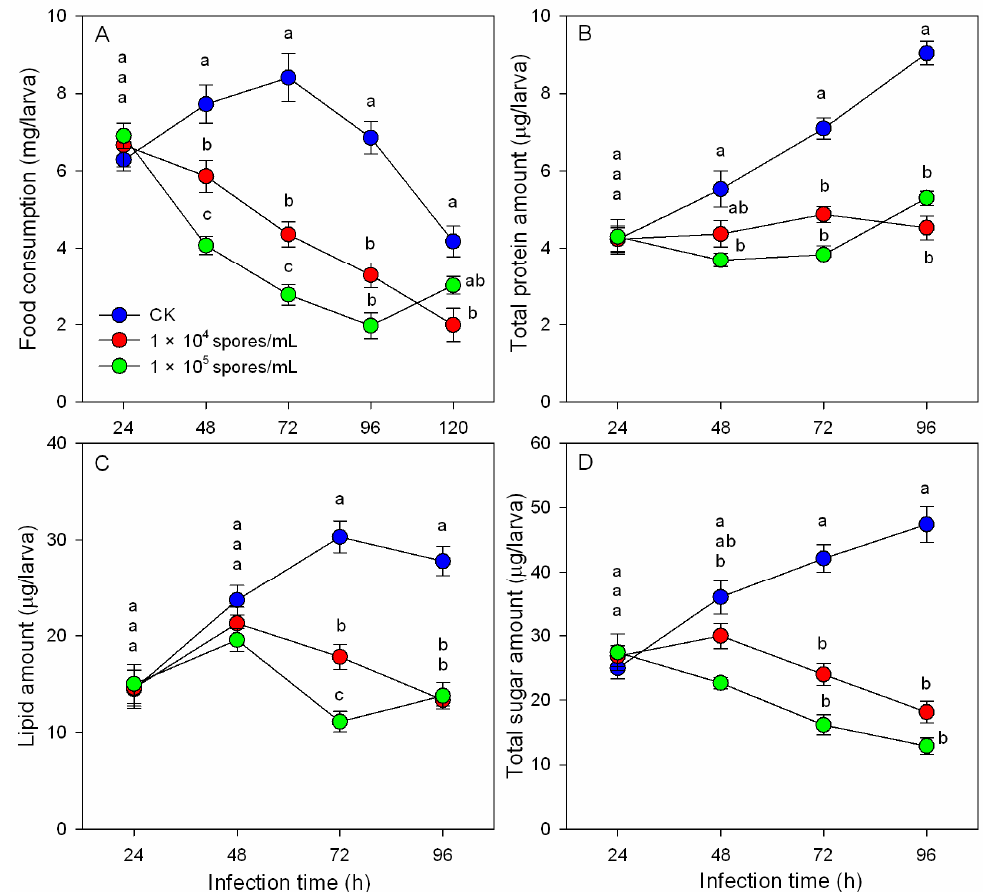
Figure 1. Effects of M. hiemalis infection on food consumption ( A ) and nutrient contents (( B ), protein amount; ( C ), lipid amount; ( D ), sugar amount) of B. odoriphaga. Data in the figure are the mean ± SE. Different letters over the same column indicate significant differences between different spore con ‐ centration treatments at the p < 0.05 level by one ‐ way ANOVA. Different letters (a and b) over the same column indicate significant differences between different spore concentration treatments at the P<0.05 level as indicated by one ‐ way ANOVA.